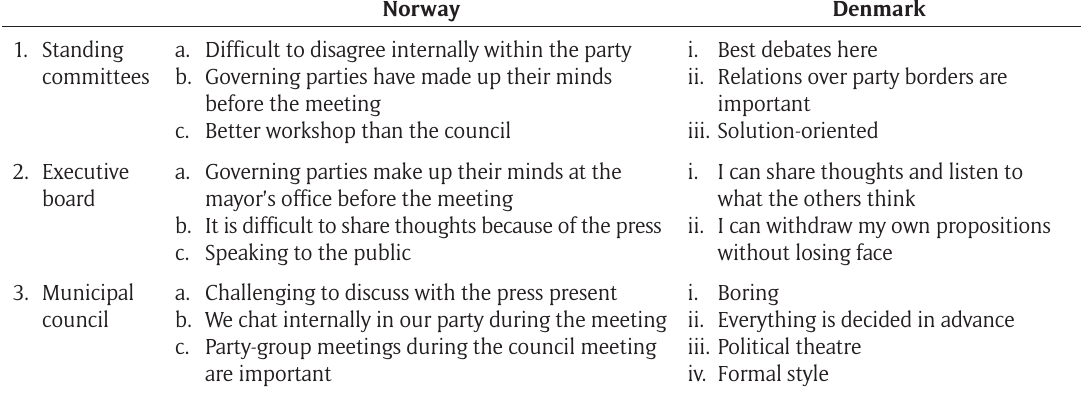
Table 2: Descriptions of meetings in Norwegian and Danish municipalities with representative quotes from informants.